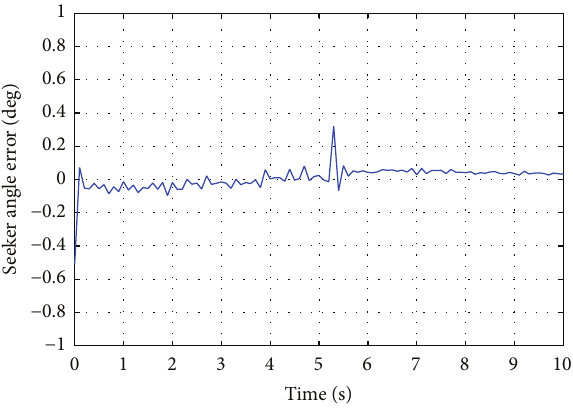
Figure 10: Missile-target engagement scenario (Case 2).